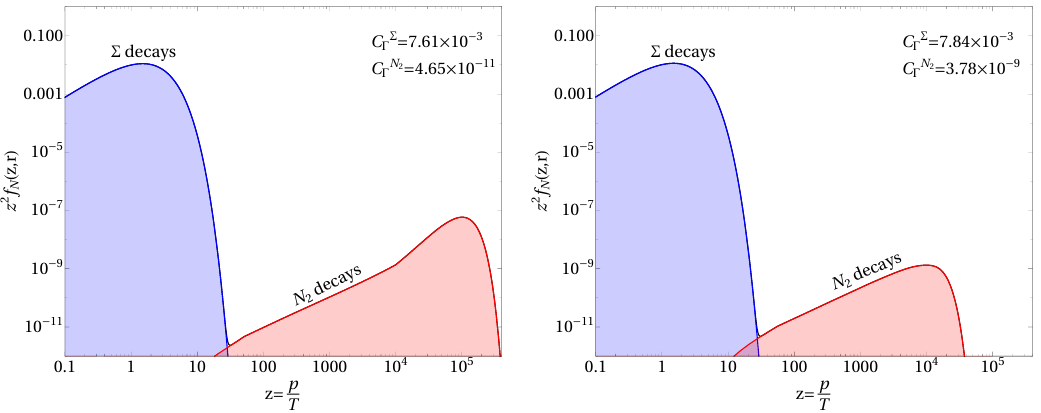
( z; r ) z 2 for 1 = 600 GeV and m N = 100 GeV ( m N = 400 GeV). 2 2 (cid:6)